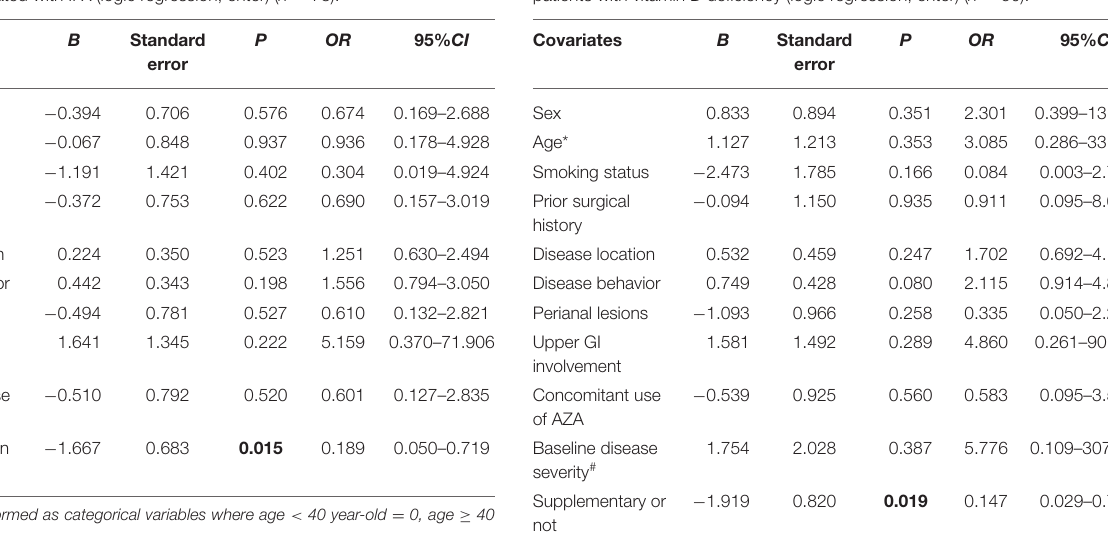
TABLE 5 | Influence of vitamin D3 supplementation on the clinical remission in CD patients with vitamin D deficiency (logic regression, enter) ( n =